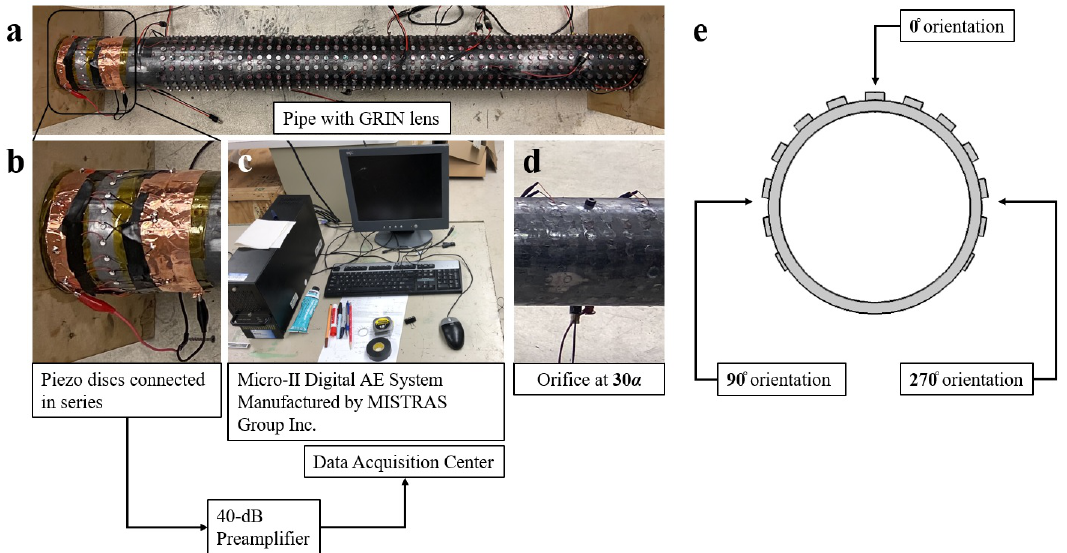
Figure 3. ( a ) Experimental configuration and schematic: pipe configuration with GRIN phononic crystal lens layer, ( b ) close- up view of piezoelectric discs connected in series, ( c ) the data acquisition system, ( d ) the orifice that was used in leak simulations and located at 30 a , ( e ) cross-section of the pipe with GRIN lens illustrating the locations of pencil lead break tests performed at focal